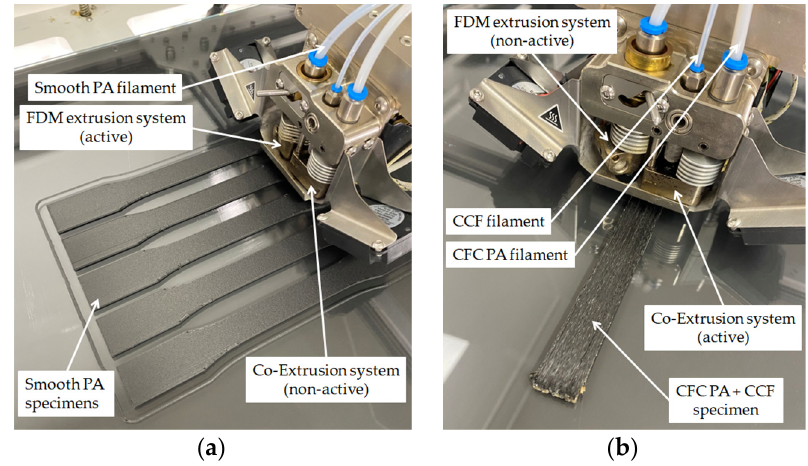
Figure 2. ( a ) AM process of Chopped FRP; ( b ) AM process of Continuous FRP.